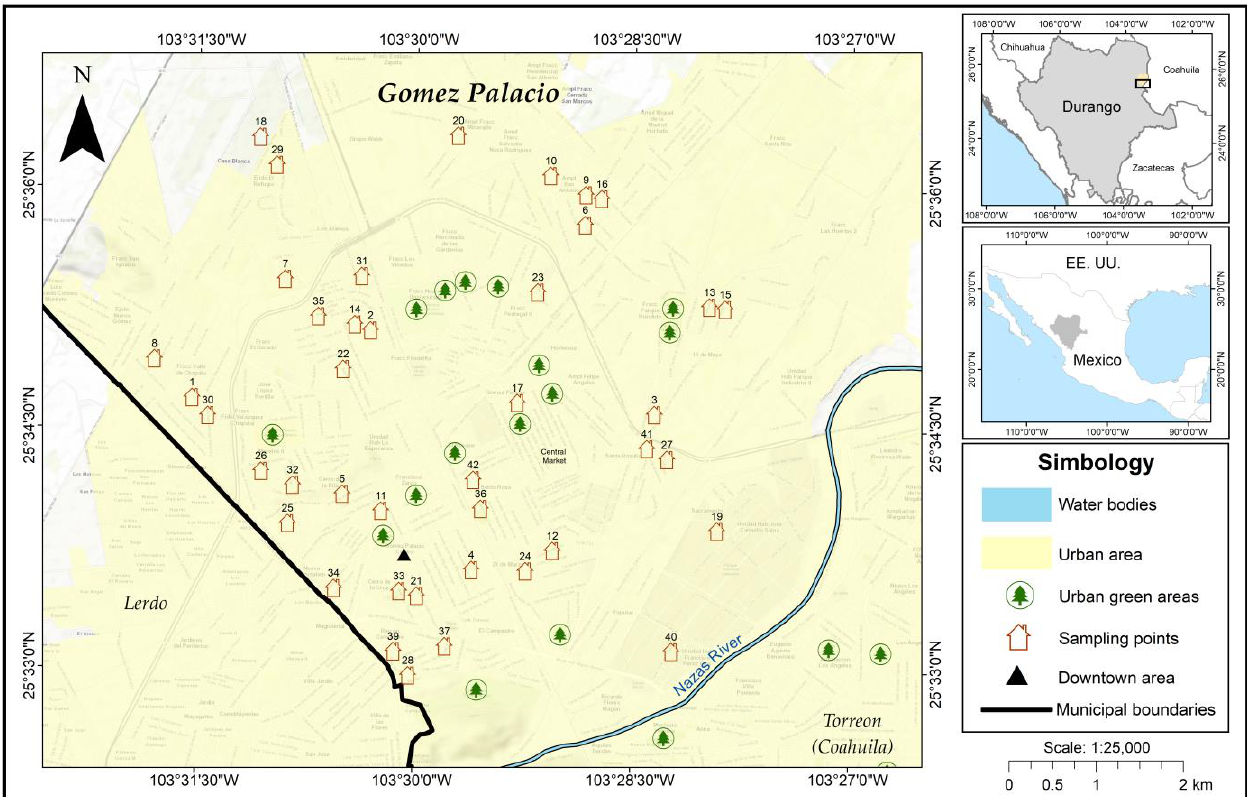
Figure 1. Sampling sites’ location.